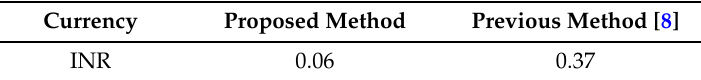
Table 8. Comparison of the EER in INR fitness classification between the proposed method and a previous method. (unit: